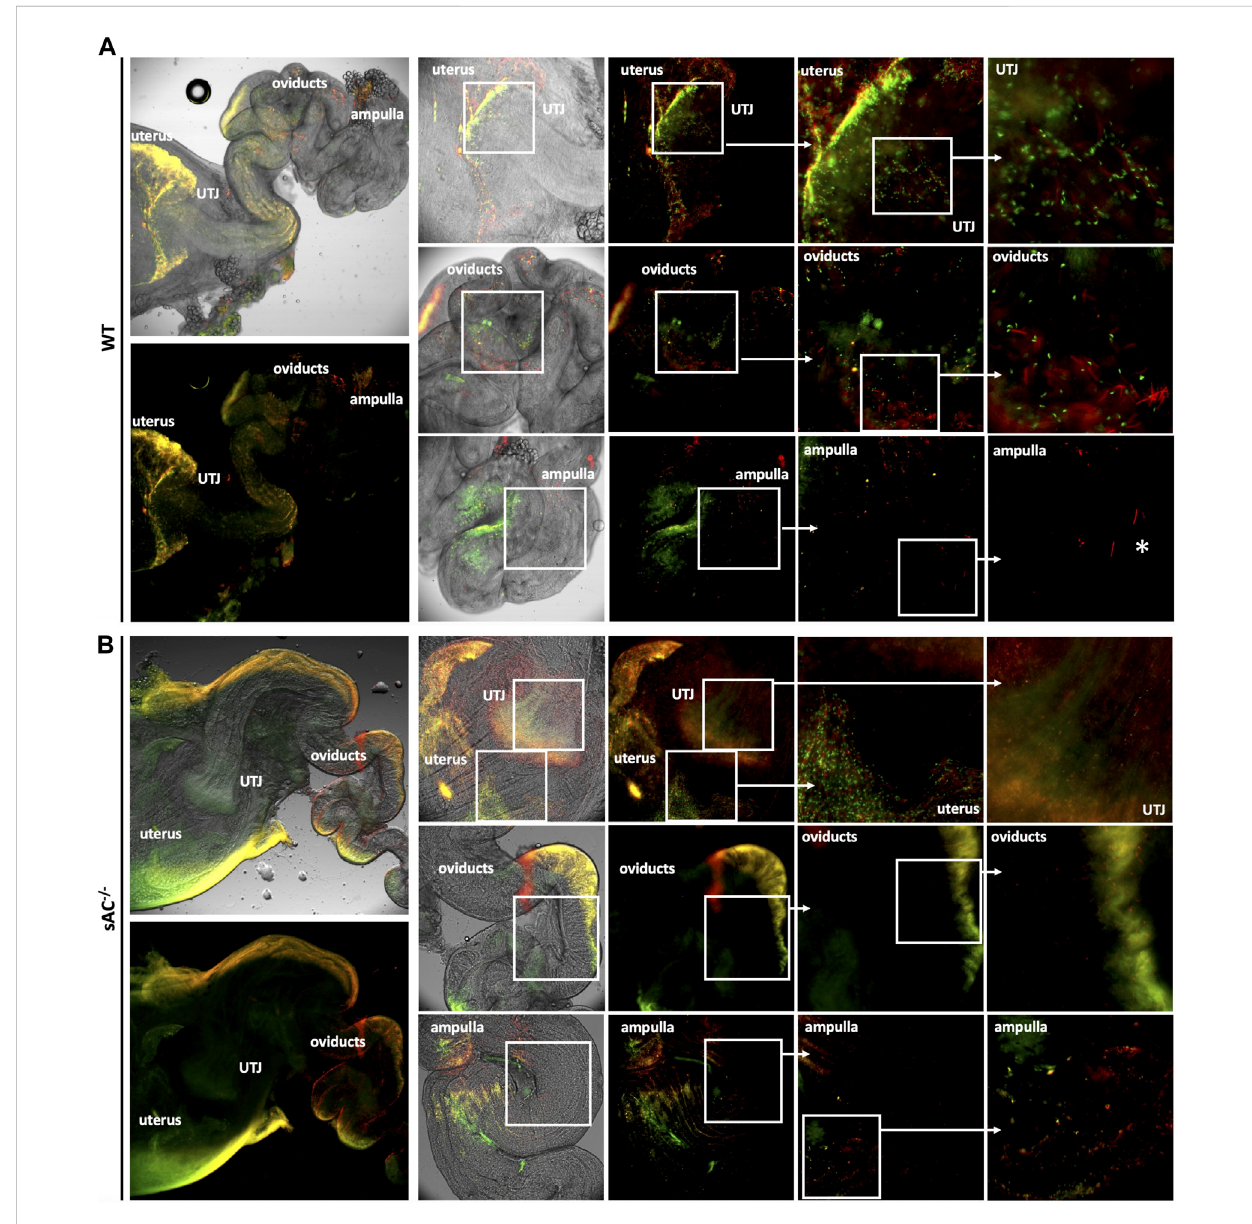
FIGURE 4 Migration of DsRed2/Acr3-EGFP/WT (A) and sAC − / − (B) sperm in the female genital tract 4 h post-copulation. Males were caged with WT females in estrous and after vaginal plug detection, they were separated. Four hours post-copulation, the female genital tracts were dissected and mounted for fl uorescence microscopy analysis using an IX73 Olympus microscope. The indicated squared regions were digitally magni fi ed and shown to the right. White asterisks depict acrosome reacted WT sperm in the ampulla. Images representative of at least 3 independent